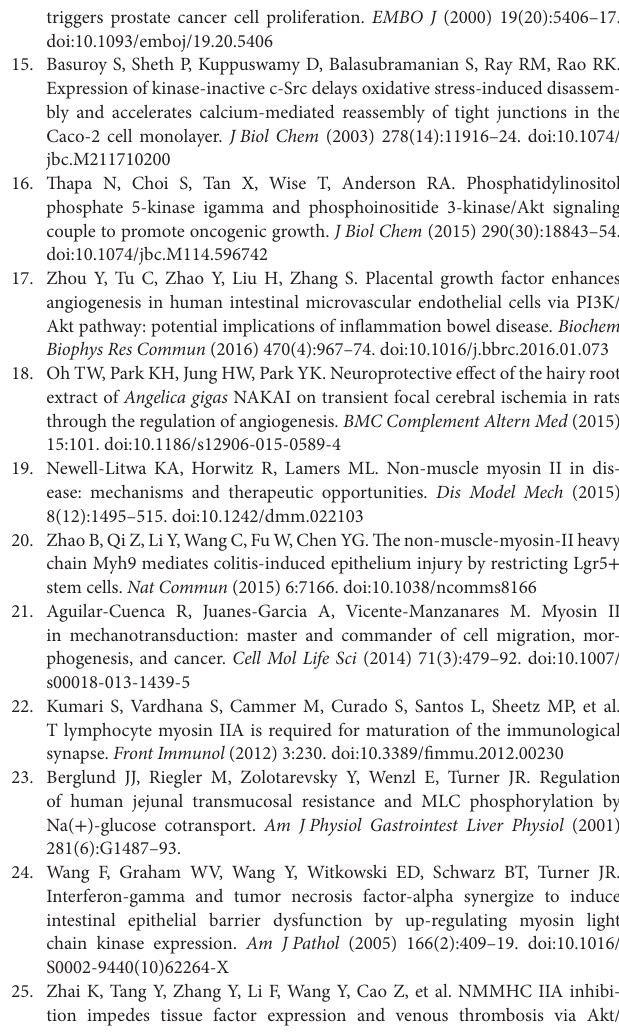
FigUre s1 | (a) The chemical structure of DT-13. (B) DT-13 showed no significant cytotoxicity on HUVECs at concentrations of 0.01–1 µM. (c) NMIIA was knocked down by a specific siRNA. FigUre s2 | The abstract graph of this